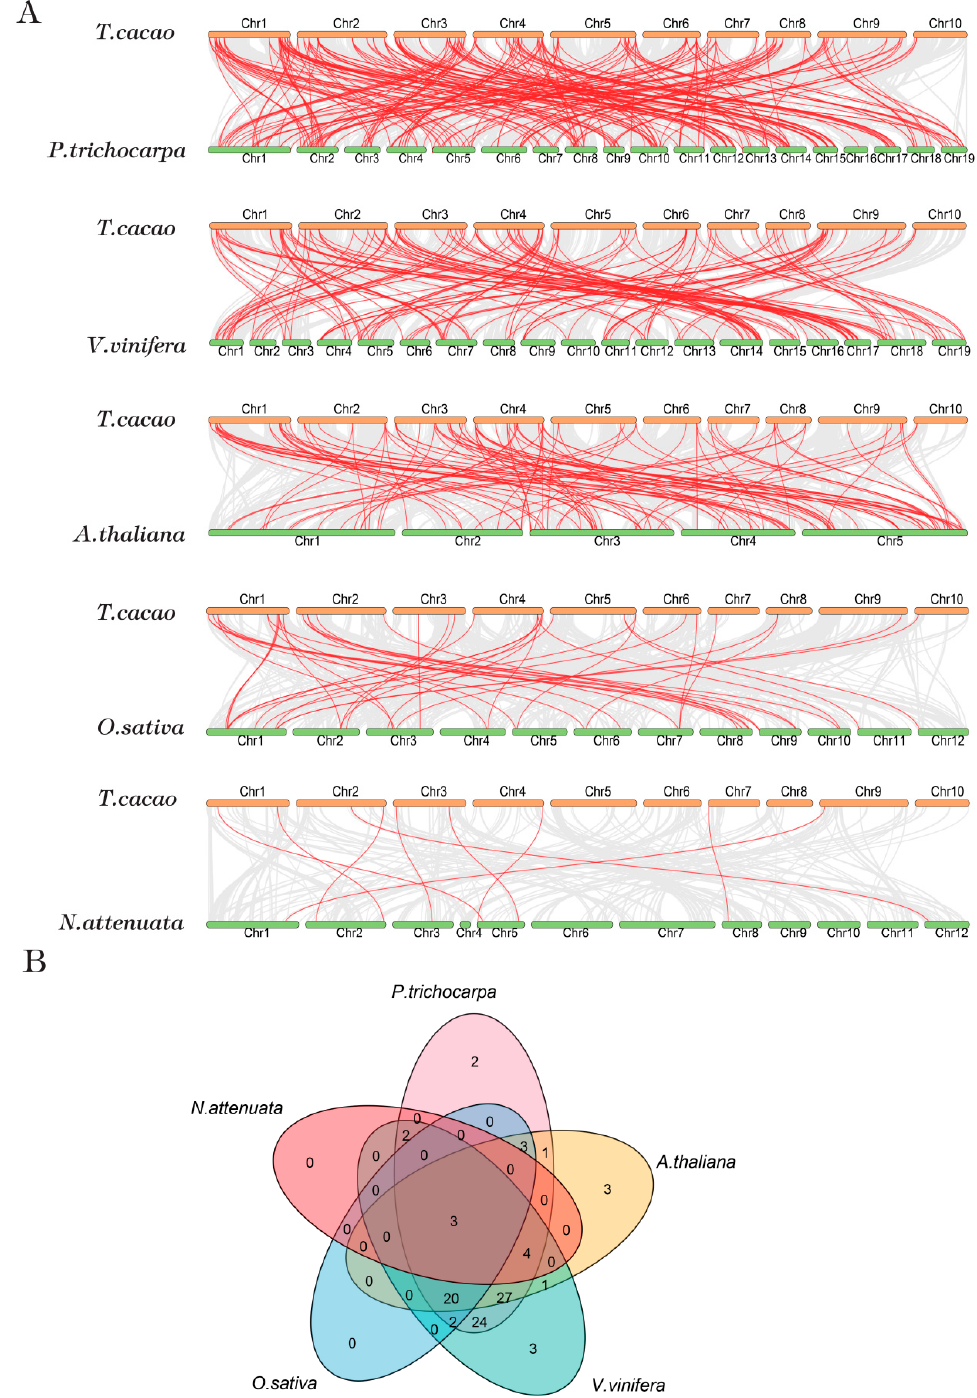
Figure 5. Venn plot and synteny analysis between Theobroma cacao and five representative species. ( A ) Synteny analysis between Theobroma cacao and five representative species. The putative colinear genes between Theobroma cacao and five representative species are marked in gray, while the syntenic R2R3 ‐ MYB gene pairs are marked in red. ( B ) We used a Venn plot to visualize syntenic R2R3 ‐ MYB gene pairs between Theobroma cacao and five representative species.